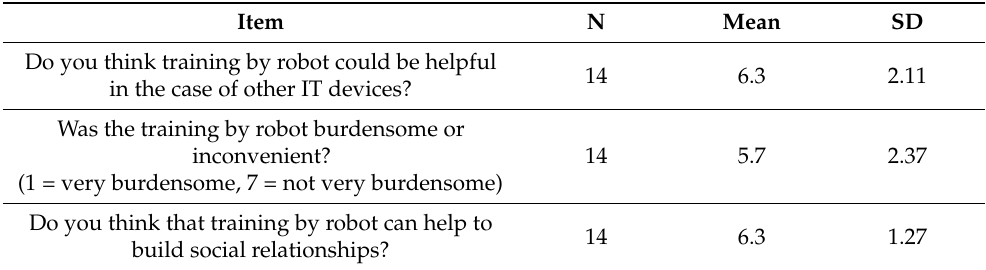
Table 8. Descriptive statistics of the items on bridging the digital